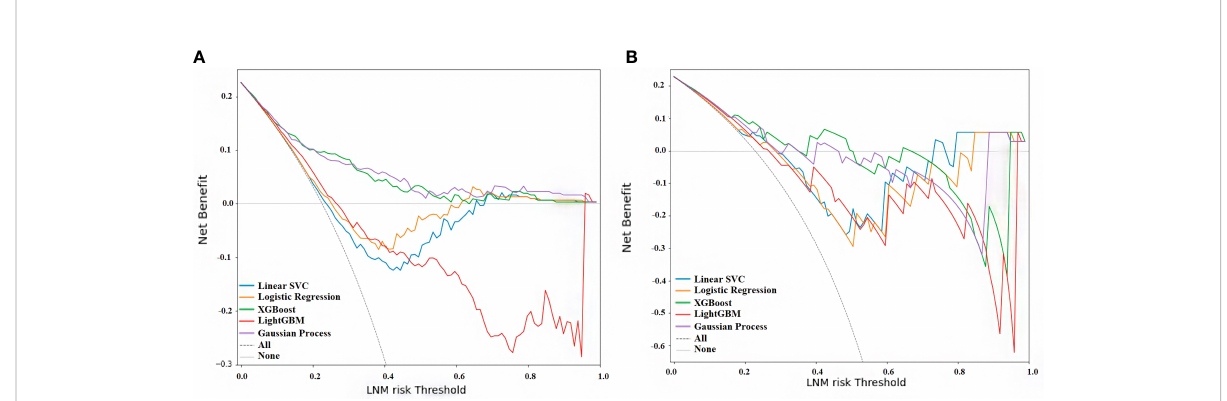
FIGURE 6 Decision curve analysis for all fi ve models. (A) Curve of cohort (I) (B) Curve of cohort II. The x-axis measures the net bene fi t, and the y-axis shows the LNM risk threshold. The blue line represents the linear support vector machine classi fi er (Linear SVC), the orange line the logistic regression classi fi er, the green line the extreme gradient boosting classi fi er (XGBoost), the red line the light gradient boosting machine classi fi er (LightGBM), the purple line the Gaussian process classi fi cation, the gray solid line the assumption that no patient with LNM, and the dashed line represents all patients with LNM